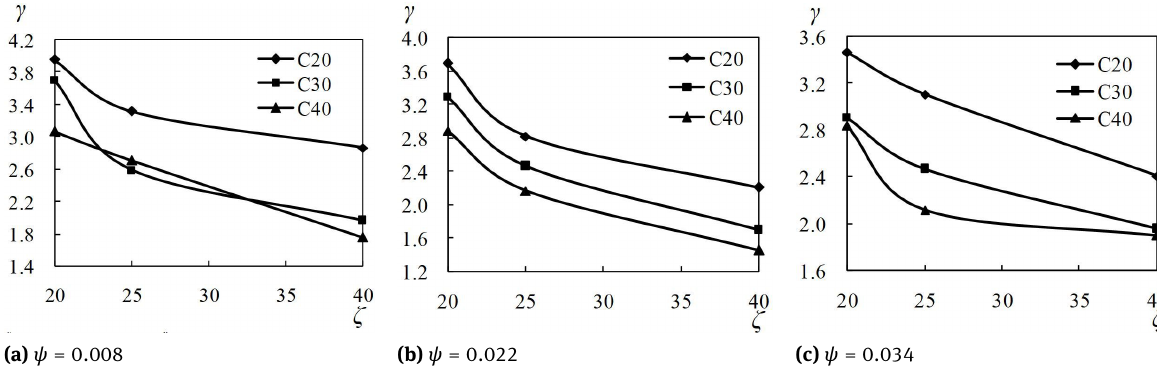
Figure 17: Confinement coeflcient versus diameter-thickness ratio of GFRP tube curves